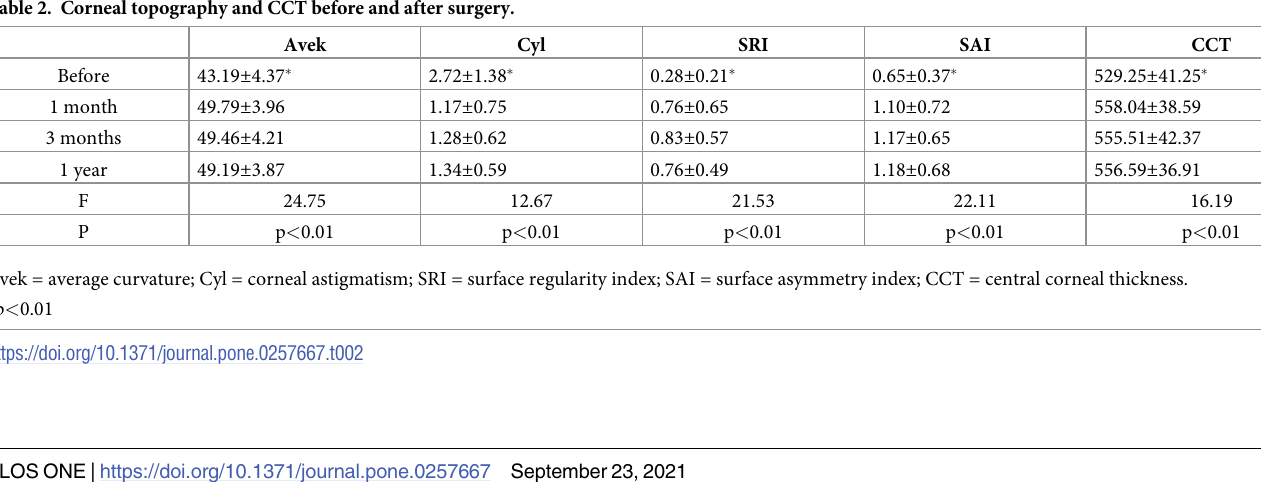
and CRF didn’t change significantly after surgery (p = 0.189 and p = 0.107 respectively)